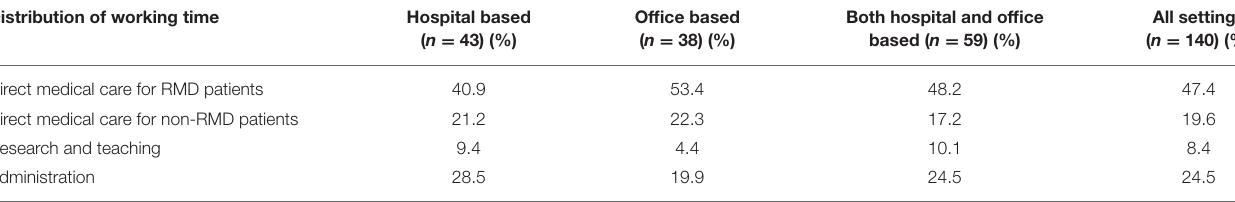
Office based Both hospital and office ( n = 43) (%) ( n = 38) (%) based ( n = 59) (%)